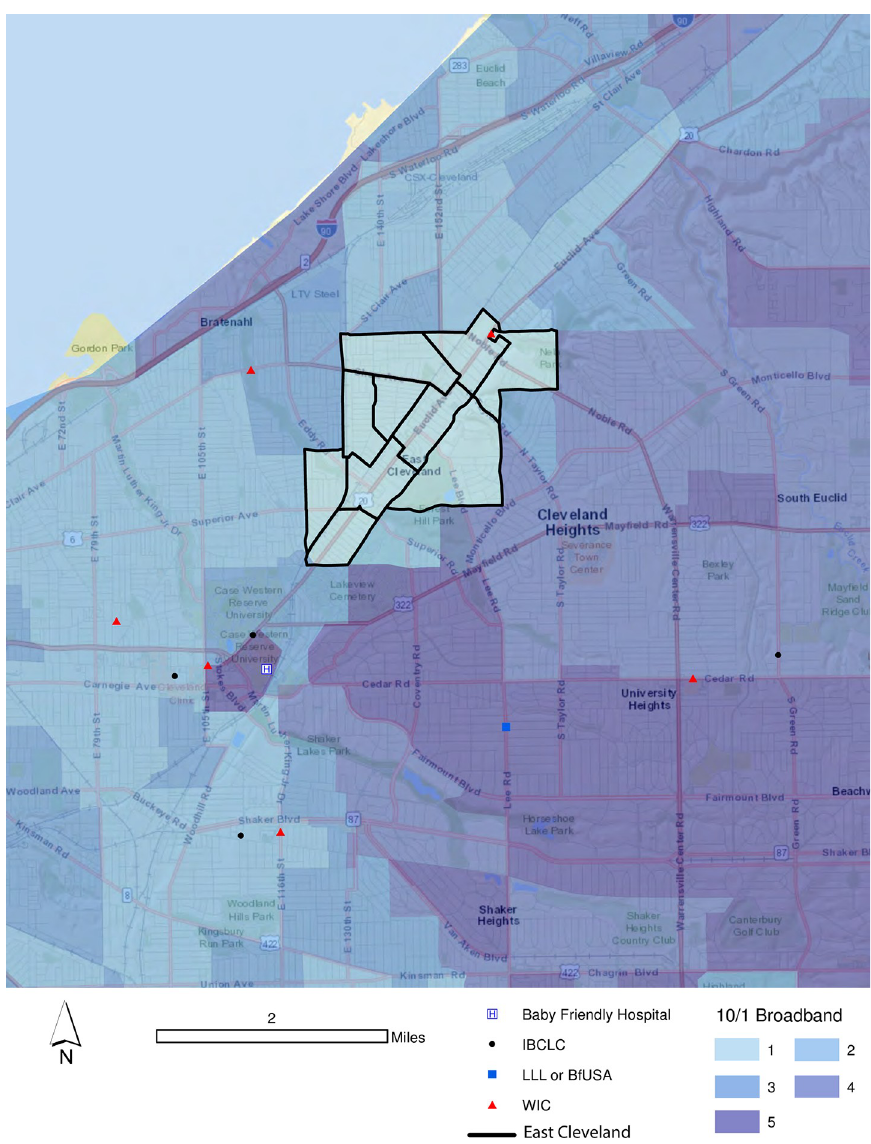
Fig 7. East Cleveland’s physical and virtual access options for breastfeeding